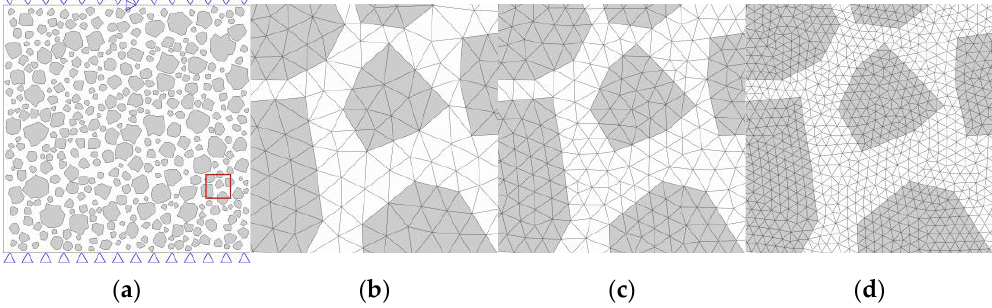
Figure 5. The meshes with different approximate element sizes: ( a ) boundary constraint condition marked by the blue triangles and the zoom area marked by the red square; ( b ) approximate size of 1.5 mm; ( c ) approximate size of 1.0 mm; ( d ) approximate size of 0.5 mm. Table 2. The bulk and cohesive elements number of the model with different mesh precision.